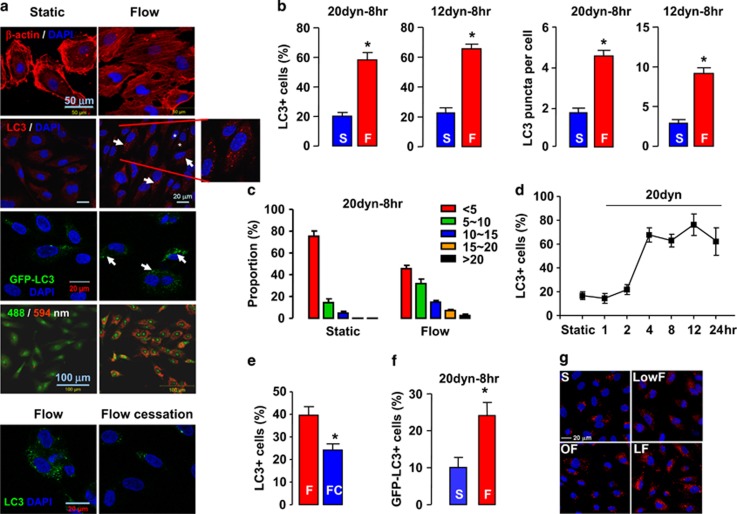
Laminar shear stress enhanced autophagic response in cultured endothelial cells. (a) Fluorescence images showing shear stress (20 dyn/cm2 for 8 h)-induced: (from top to bottom) realignment of actin fibers in human umbilical vein endothelial cells (HUVECs); accumulation of LC3 puncta (arrows) in HUVECs (asterisks indicate punctate LC3- cells); puncta accumulation of GFP-LC3 (arrows) in transfected telomerase-immortalized human microvascular endothelium cell (TIME) cells; acidification of autolysosomes detected with acridine orange staining (red fluorescence represents acidic vesicles); flow cessation decreased the abundance of GFP-LC3 in shear-adapted TIME cells. (b) The average number of LC3 puncta per cell and proportion of punctate LC3+ cells under static (S) and laminar flow (F) conditions. (c) Comparison of the proportion of cells containing different numbers of LC3 puncta under static and flow conditions. (d) Time course of laminar flow-induced autophagic response in HUVECs. (e) Effects of flow cessation (FC) on punctate LC3 in cells adapted to flow for 8 h. (f) Semi-quantitative data showing the effect of laminar flow on GFP-LC3 puncta accumulation in transfected TIME cells. (g) LC3 immunofluorescence showing that low-magnitude flow (LowF; 4 dyn/cm2) or oscillatory flow (OF; ±5 dyn/cm2 at 1 Hz) did not have the same effect as laminar flow (12 dyn/cm2) on autophagy induction. Data are mean±standard error of the mean (S.E.M.). *P<0.05, unpaired t-test, n=3–5. LF, laminar flow